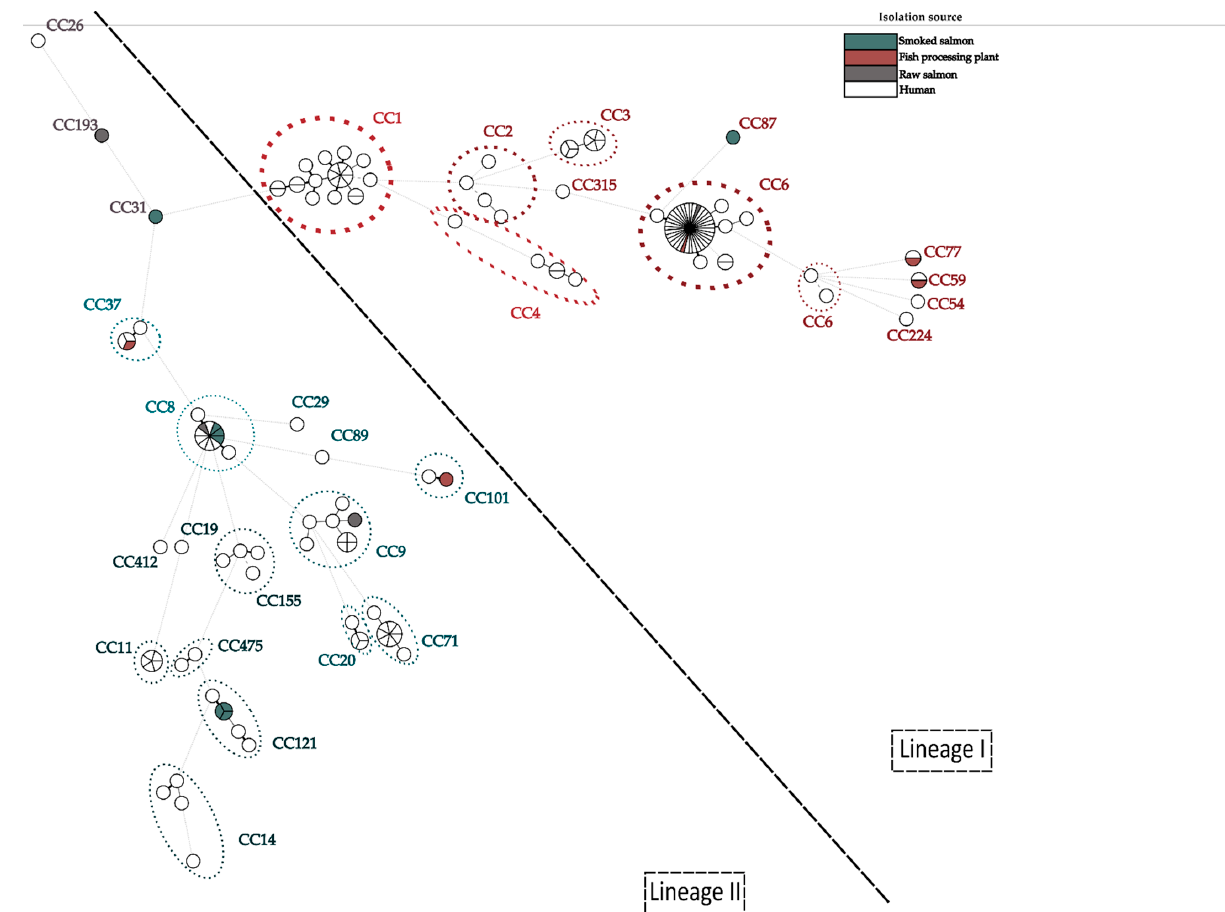
Figure 6. A minimum spanning tree (MST) representing the comparison of the virulence profiles of L. monocytogenes isolated and analyzed in this study with the virulence profile of published genomes recovered from listeriosis cases from Europe. The analysis was made on the base of MVLST profiles using a single linkage method. The graph was created with BioNumerics v7.6.